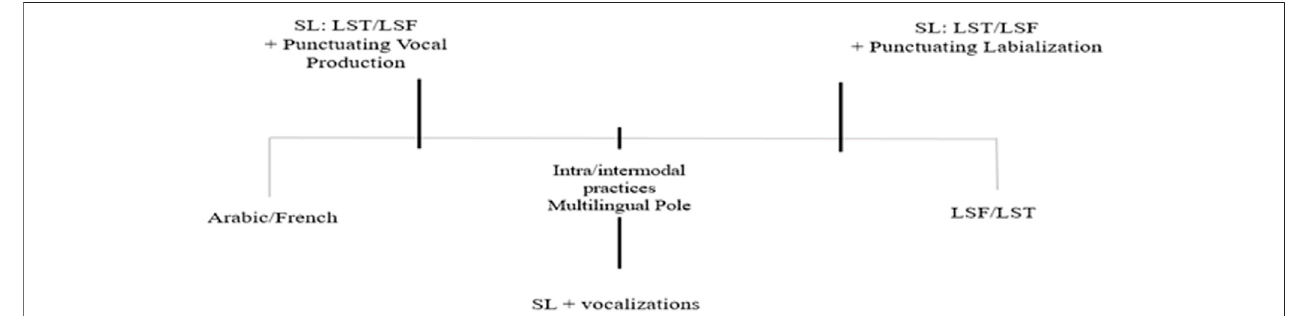
FIGURE 3 | Khayech (2011) inter/intra model